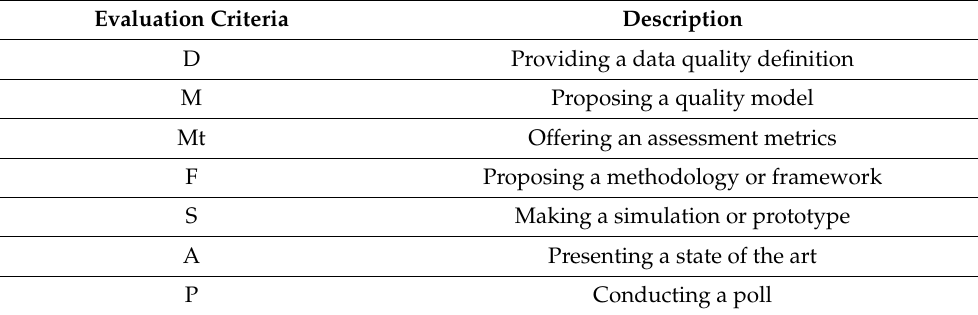
Table 11. Definitions of the evaluation criteria.